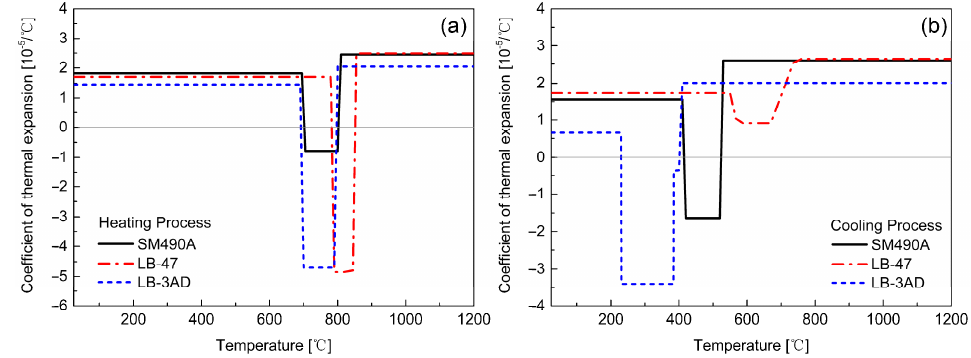
Figure 5. CTE of the welded components during the heating and cooling processes: ( a ) heating process; ( b ) cooling process.